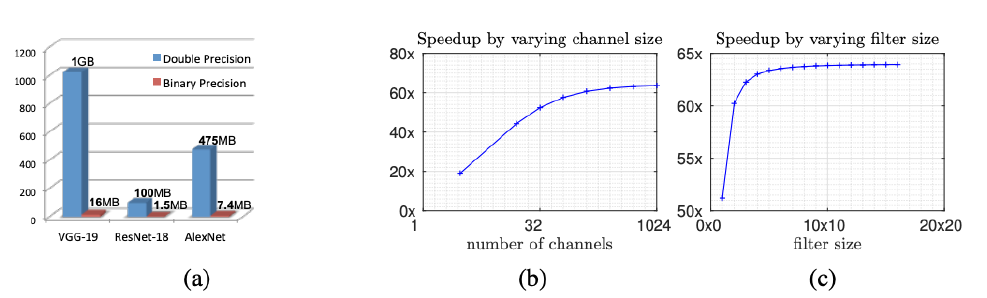
Figure 1. This figure shows the efficiency of binary convolutions in terms of memory ( a ) and computation ( b , c ). ( a ) contrasts the required memory for binary and double precision weights in three different architectures(AlexNet, ResNet-18, and VGG-19). ( b , c ) show the speed improvement achieved by binary convolution under ( b ) different number of channels and ( c ) different filter size. Taken from [15].